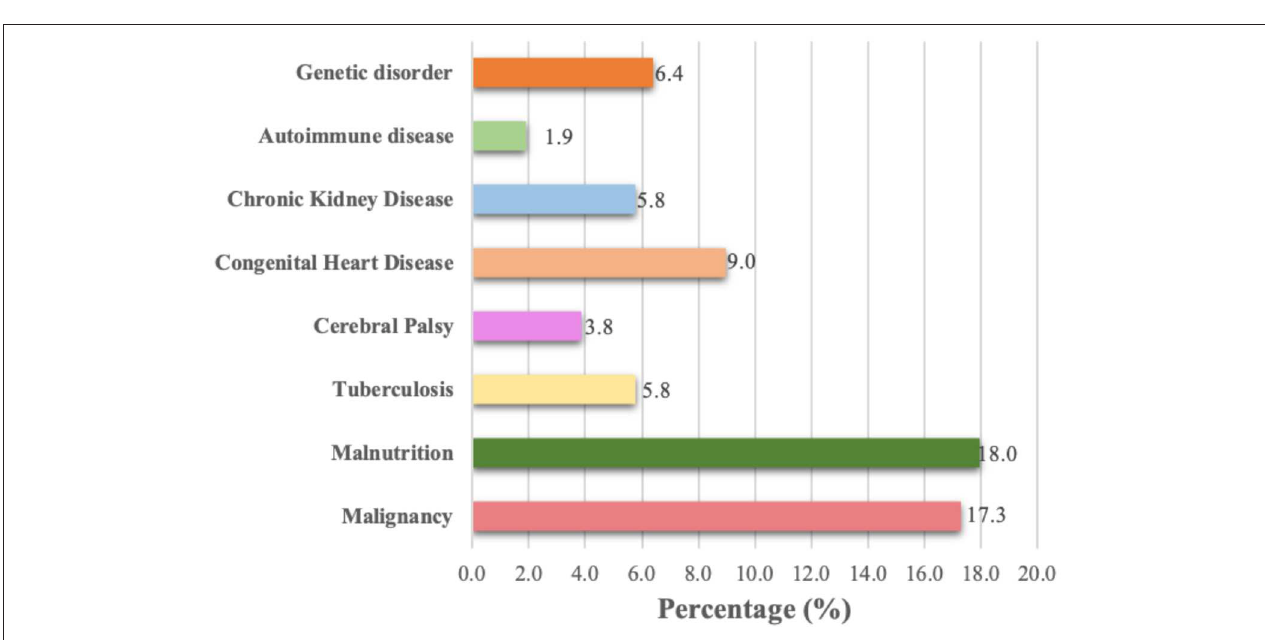
FIGURE 3 | Comorbidities among confirmed COVID-19